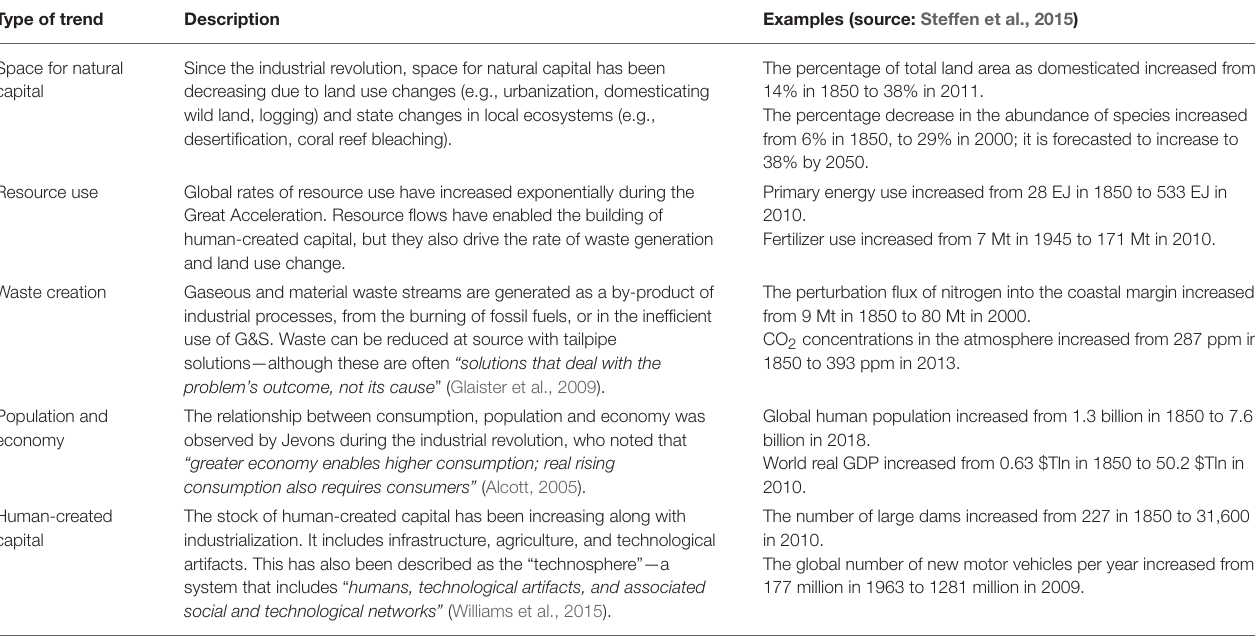
TABLE 1 | Trends in the Great Acceleration with examples of changes in indicators. Type of trend